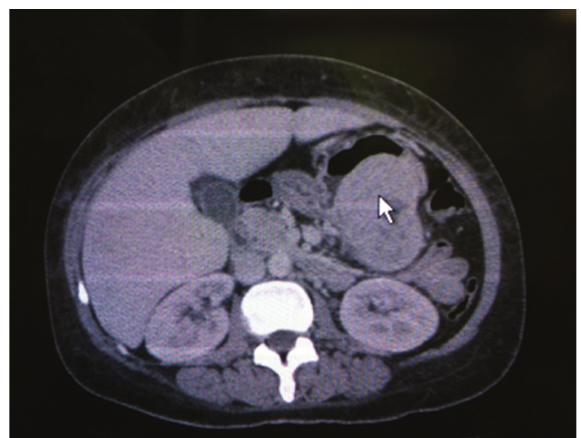
Figure 3: (H-E, 40x): Lobular and solid tumor infiltrating the muscular layer of gastric wall.